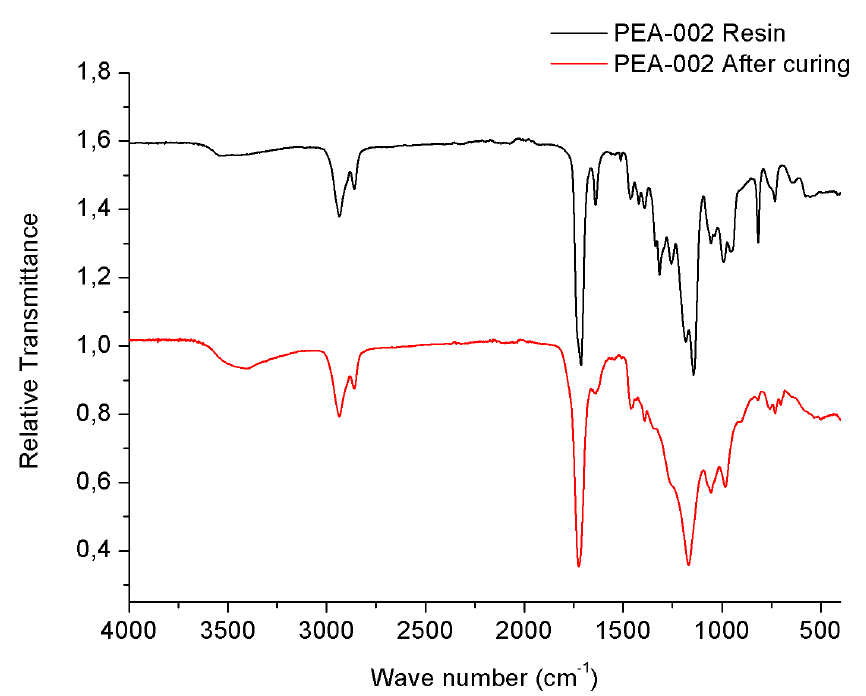
Figure 6. FT-IR-spectra of PEA-002 before and after UV-curing.